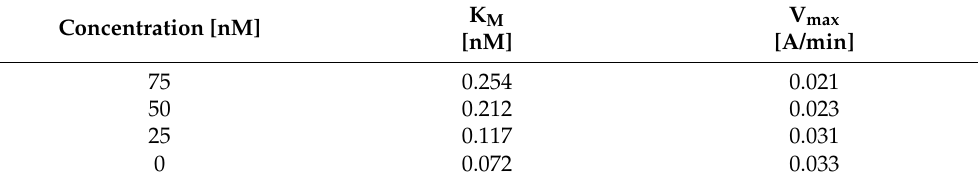
independent experiments) of BChE (* p < 0.01; Kruskal–Wallis test). 3 —selectivity for AChE = IC 50